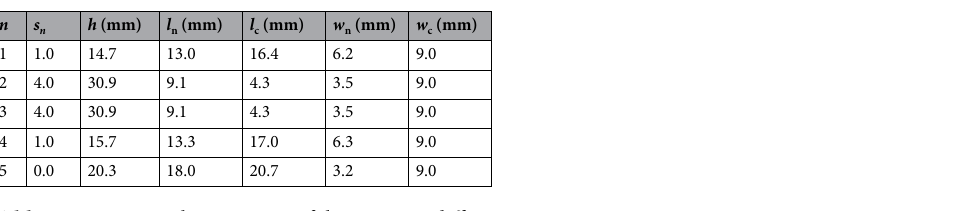
Table 1. Geometrical parameters of the